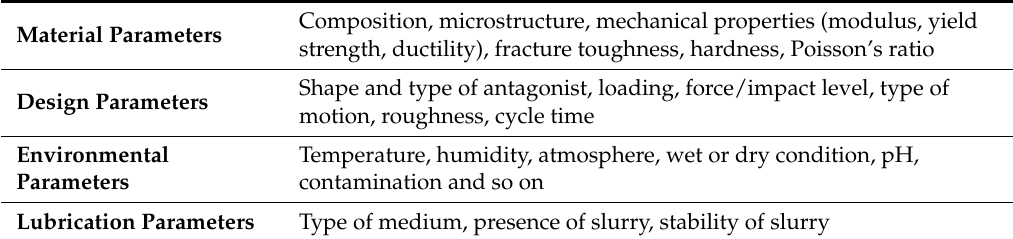
Table 1. List of factors affecting wear resistance of materials (modified from